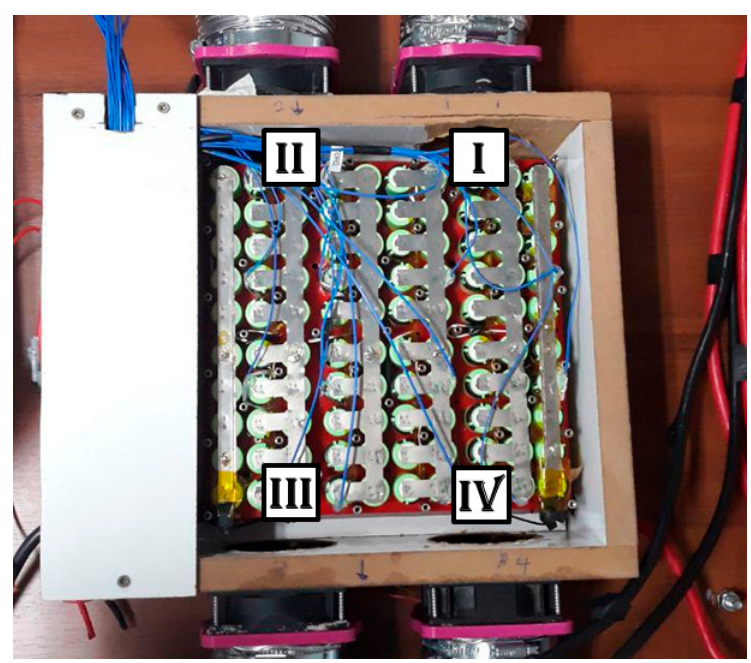
Figure 11. Battery vent configuration, inlet Fans I and II, outlet fans III and IV.